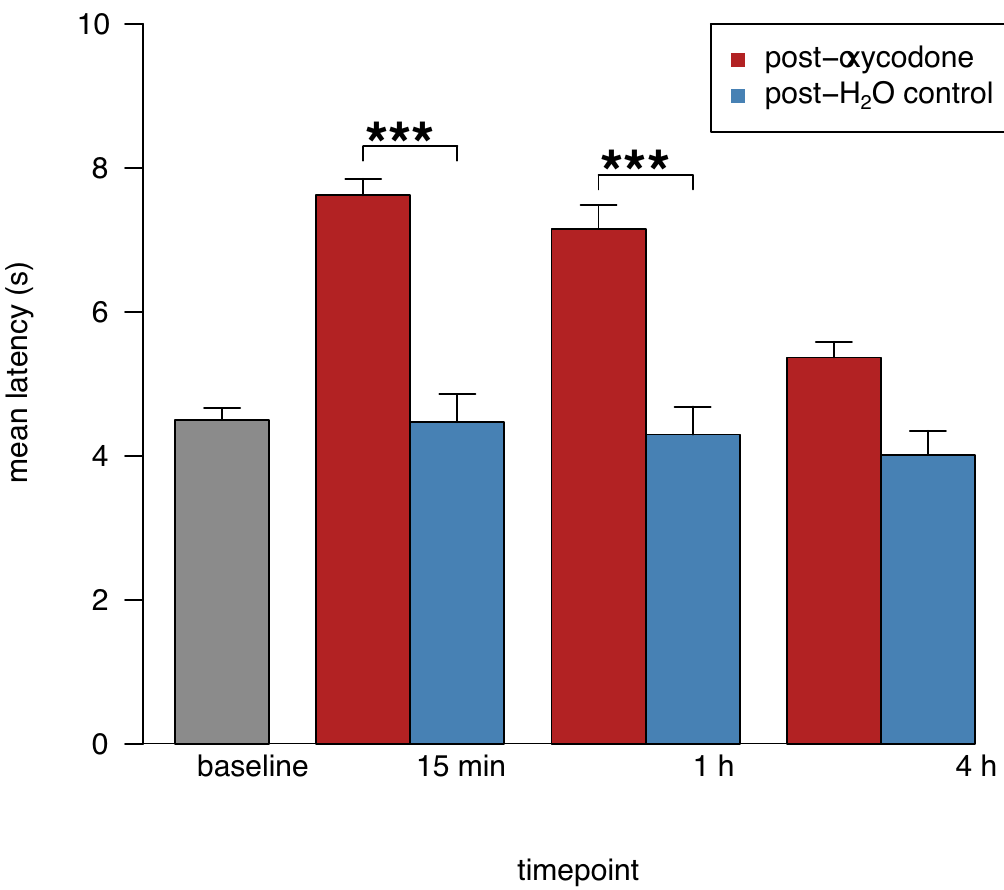
Fig 3. TailTimer detects acute changes in tail withdrawal latency following oral oxycodone exposure. Pain thresholds of SD males ( n = 8) were evaluated at 15 min, 1 h, and 4 h post-gavage of 3 mg/kg oxycodone or distilled water at a controlled water temperature of 48˚C ± 0.25 and a fixed, low water mixing speed (setting 1). Latencies were significantly longer at 15 min and 1 h, but not 4 h, post-gavage of oxycodone versus distilled water. Following gavage of the distilled water control, latencies were not significantly different from baseline at any time point. Mean latencies reflect the average of the (two–four) measurements per individual rat averaged across timepoints. Data are expressed as mean ± SEM; ��� p < 0.001.